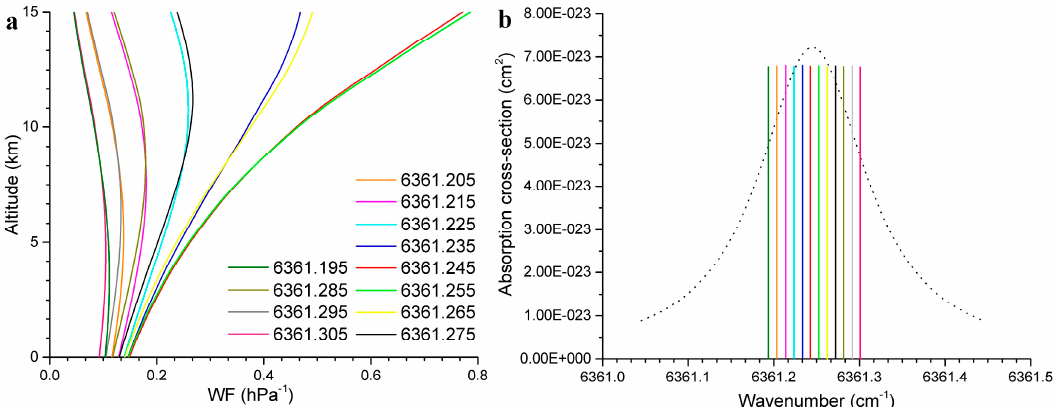
Figure 14. Weighting functions (WF) for different wavenumbers: ( a ) shows the relationship between the WF and altitude. Different colors represent different wavenumbers as per the figure legend; In ( b ), the dotted curve denotes the spectrum for R18, and the colored straight lines represent the wavenumbers shown in the left-hand panel, using the same color key. The spectrum shown in the right-hand panel was calculated using T = 296 K and p = 101325 Pa, and the line has a Voigt shape.